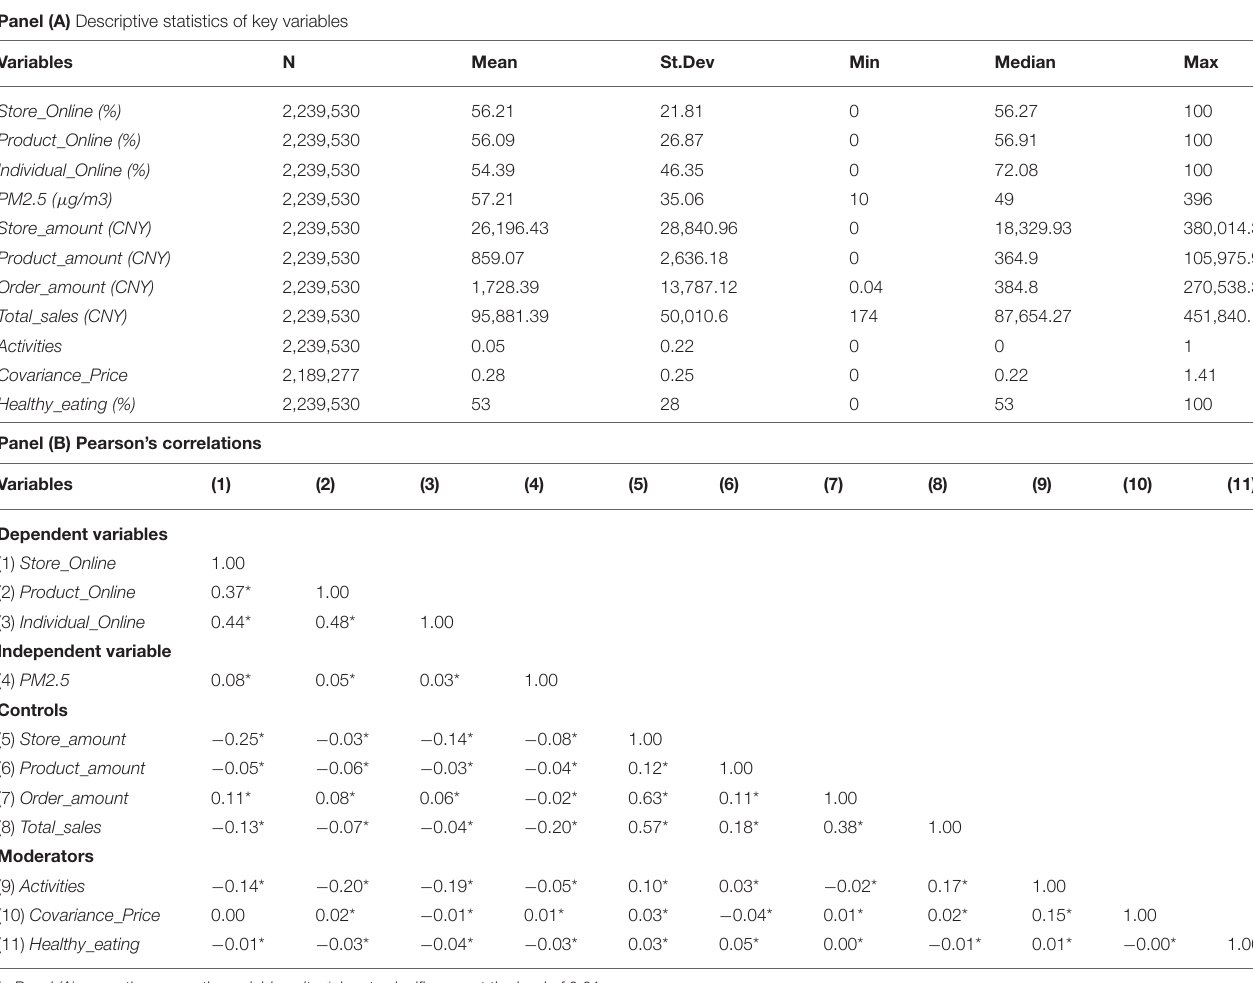
TABLE 2 | Descriptive statistics and correlations.